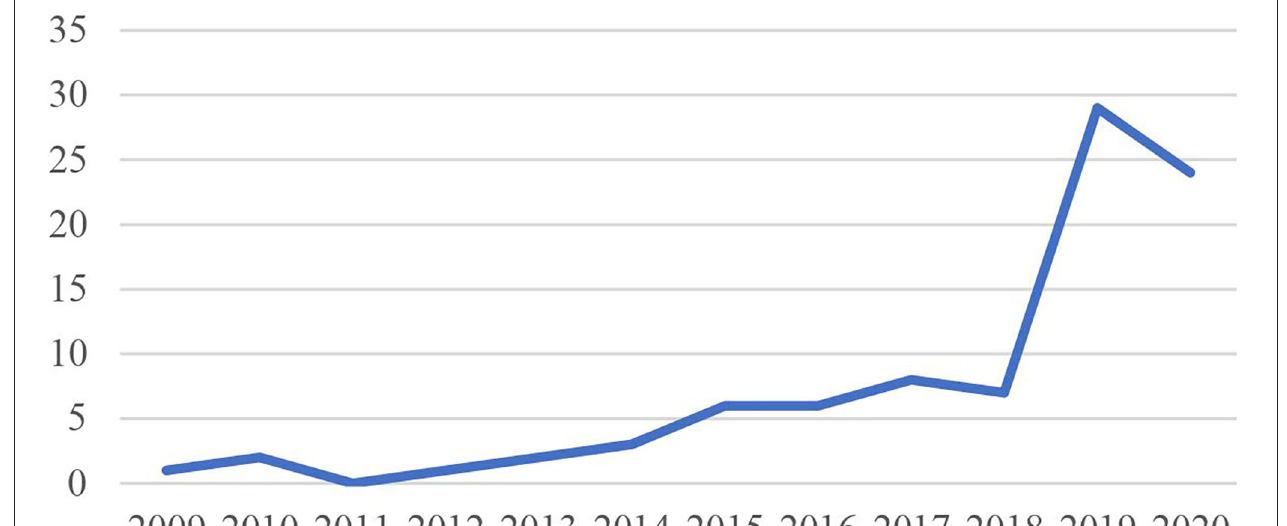
FIGURE 2 | Annual distribution of articles on knowledge